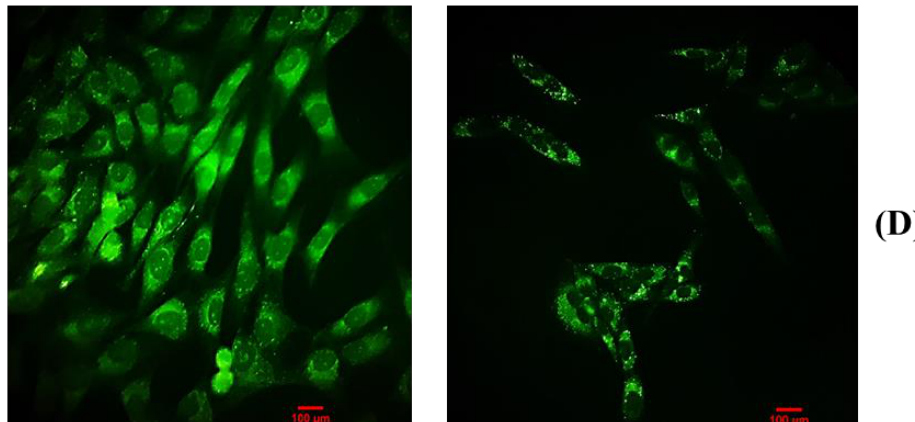
Figure 9. ( A ) Phase contrast images of MG-63 cells. ( B ) Scanning electron micrograph (SEM) images of MG-63 cells. ( C ) Acridine orange and ethidium bromide (AO/EtBr) staining of MG-63 cells with a fluorescence microscope. ( D ) Rhodamine-123 staining of MG-63 cells with a fluorescence microscope. ( a ) Untreated MG-63 cells, ( b ) MG-63 cells treated with BDCe fraction (37.53 μM) for 24 h. The arrow indicates live (L), early apoptosis (EA), late apoptosis (LA), and necrotic cells (N).